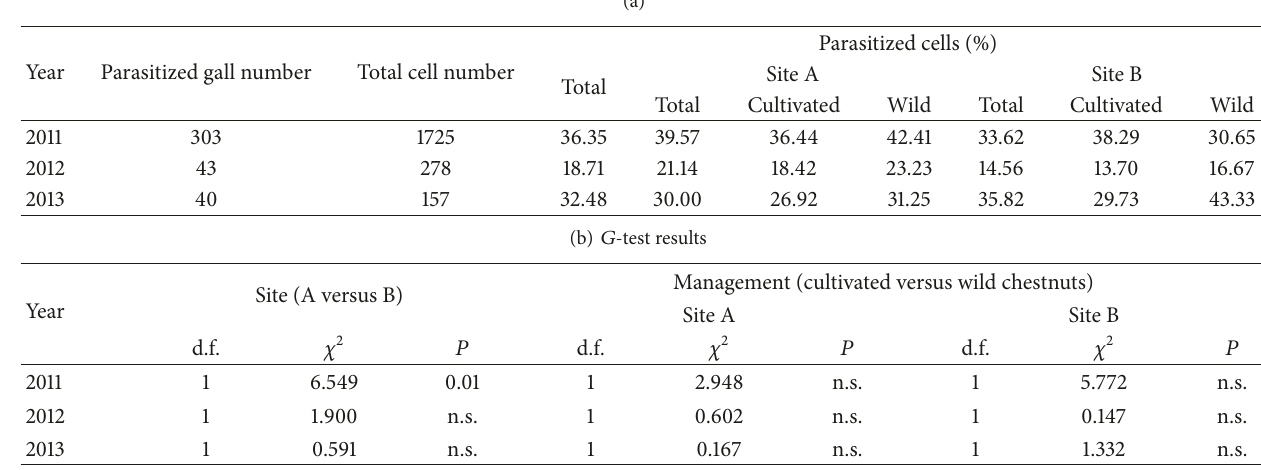
Table 3: Parasitized cells within Dryocosmus kuriphilus galls collected from cultivated and wild chestnuts in the two study sites (site A =